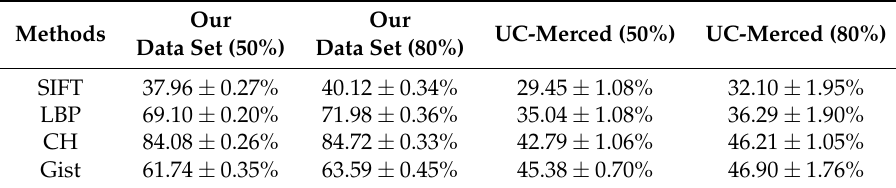
Table 6. Overall Accuarcy (OA) test on RSI-CB and UC-Merced.